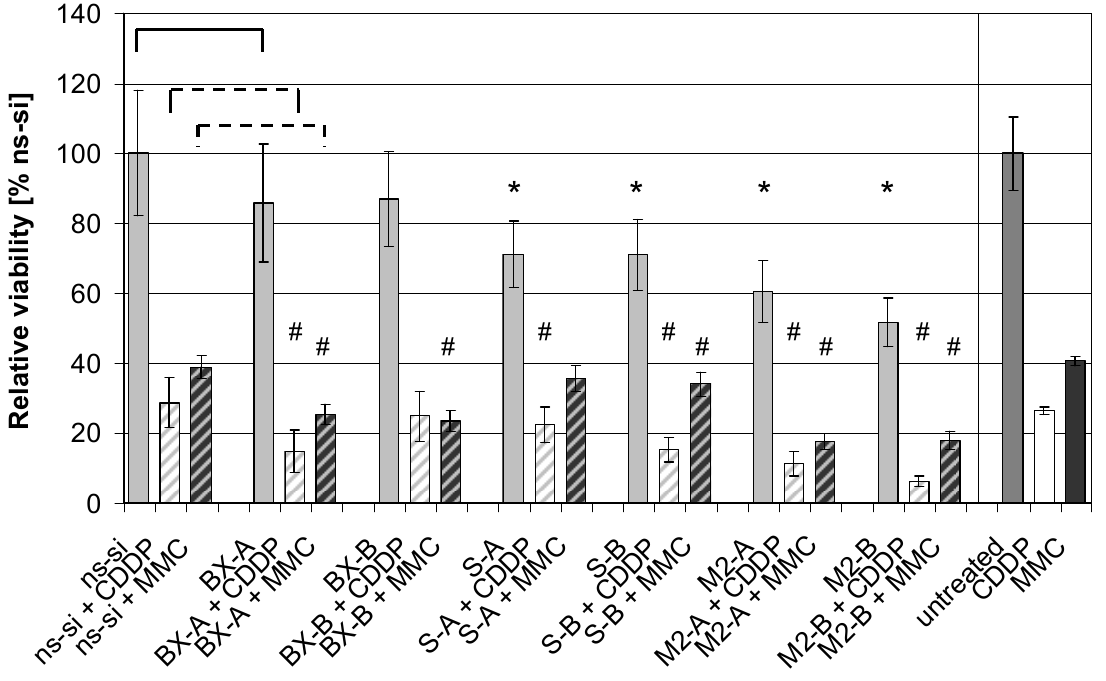
Figure 4. Reductions in viability of EJ28 cells after siRNA-mediated inhibition of Bcl-xL and survivin, with or without subsequent chemotherapy (CT). EJ28 cells were transfected with a total of 40 nM siRNAs for four hours. Twenty-four hours after transfection start, cells were treated with 2.1 µg/mL cisplatin (CDDP) for 24 h or with 0.9 µg/mL mitomycin C (MMC) for two hours. Cell viability was examined 96 h after transfection. Values shown are relative to the control siRNA “ns-si” (=100%, for all siRNA treatments) or relative to untreated cells (only for CDDP and MMC single treatments) and are averages of a fourfold determination. Error bars represent the 95% confidence interval. An unpaired Student’s t -test was used to compare the differences in cell viability between target-specific siRNA and ns-si treated cells ( * p ≤ 0.05) as well as between target-specific siRNA + CT and ns-si + CT treated cells ( # p ≤